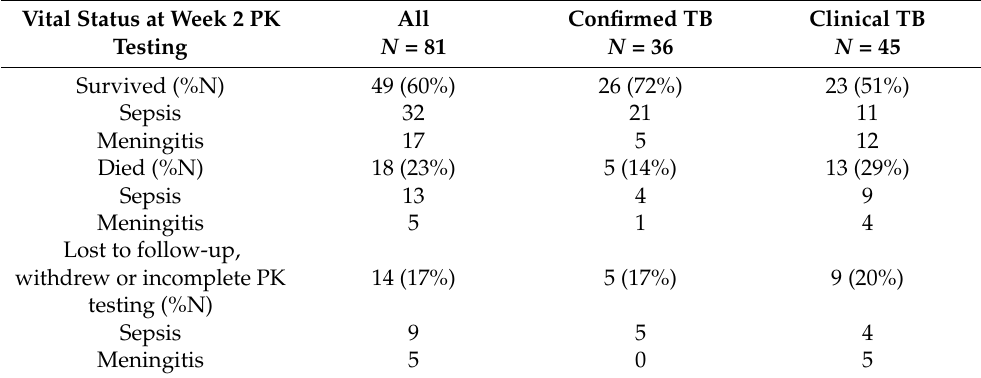
Table 2. Vital status at week 2 pharmacokinetic testing. TB: Tuberculosis.